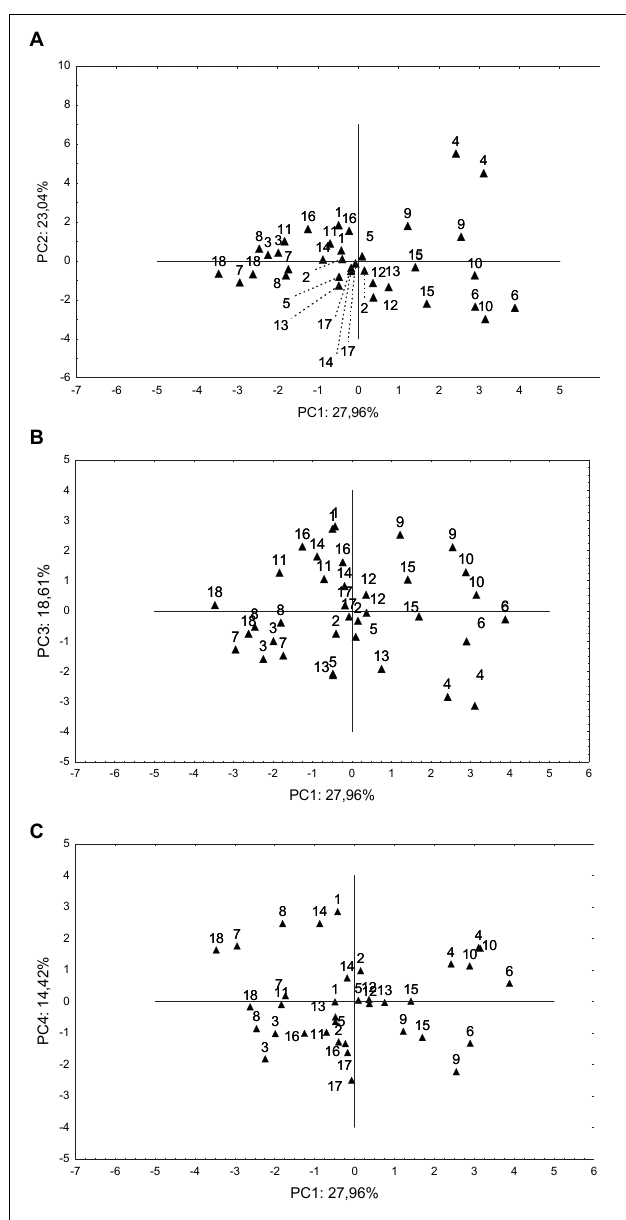
FIGURE 3 | PCA Distribution of samples: (A) PC1 × PC2, (B) PC1 × PC3, and (C) PC1 × PC4. Note | Numbers are related to specific samples mentioned in Table 1 .